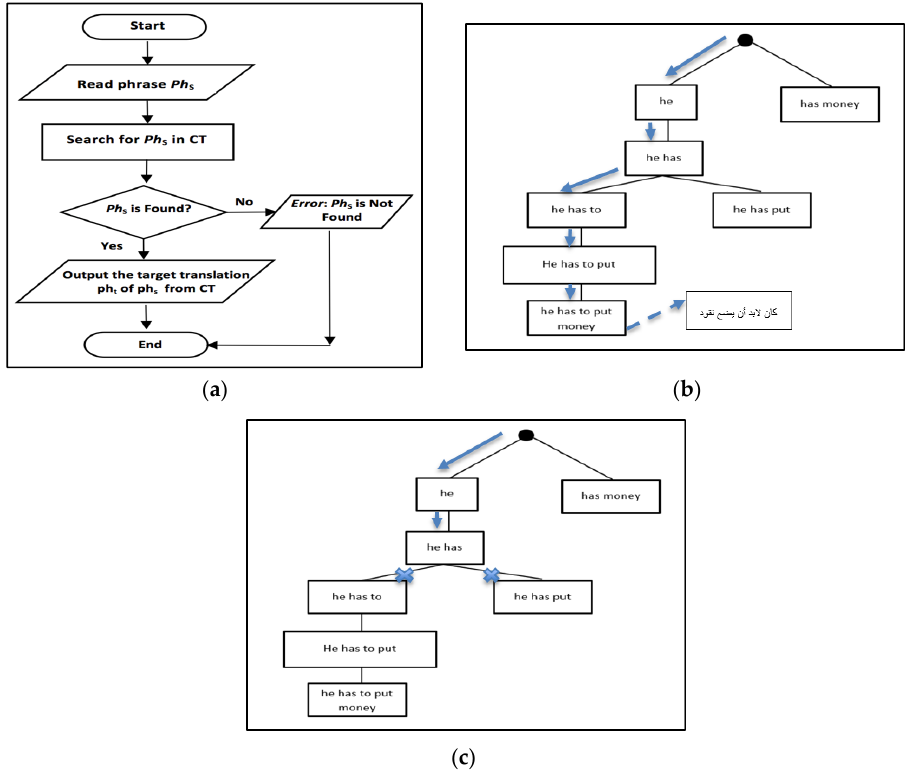
Figure 3. ( a ) Flowchart of the translation process; ( b ) An example showing the translation of the sentence “he has to put money”; ( c ) An example showing the translation of non-existent sentence in the Corpus Trie “he has money”.